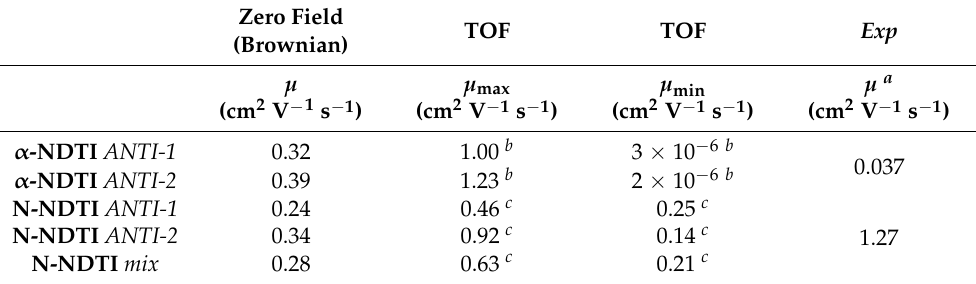
Table 3. Computed Brownian (zero field) and TOF mobilities for α -NDTI and N-NDTI . Zero Field TOF TOF Exp (Brownian) µ